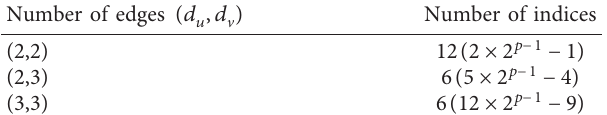
Table 1: Edge partition of nanostar dendrimer D Number of edges ( d u , d v